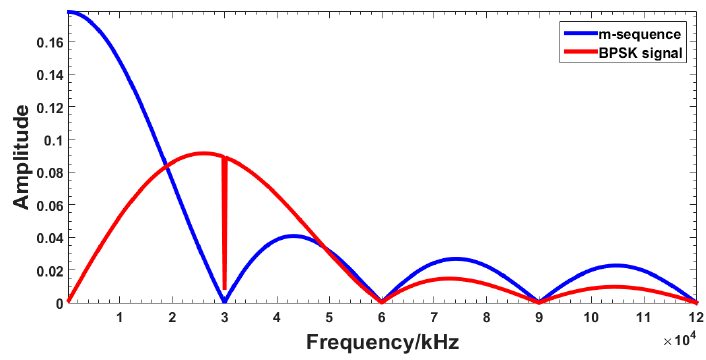
Figure 3. Spectrums of m-sequence and BPSK signal.